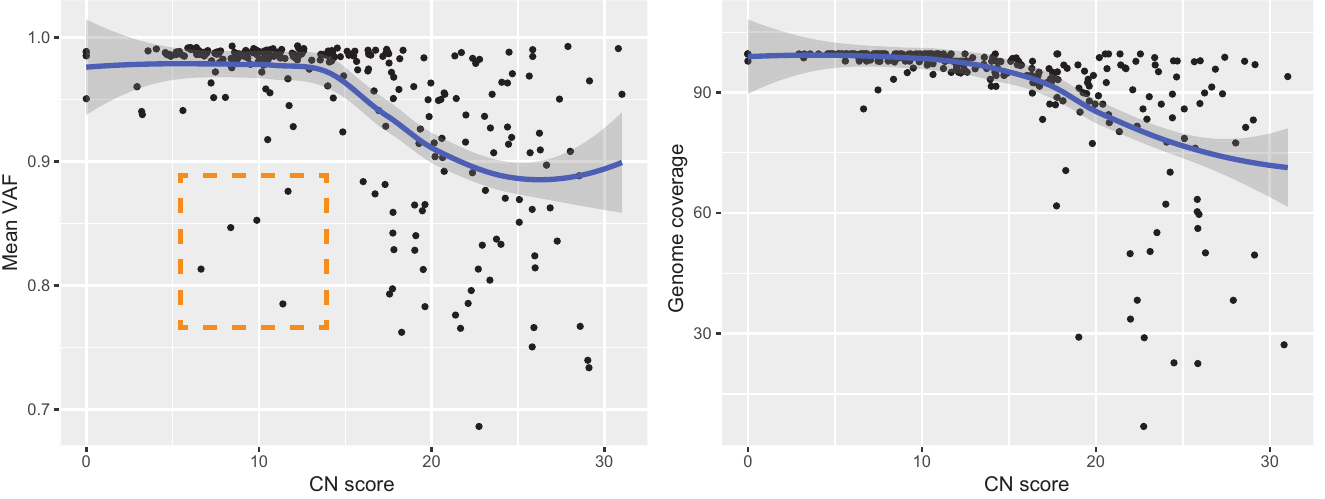
Fig 2. Genomic features in relation to RNA abundance at diagnosis. Average variant allele frequency (VAF) in function of RNA abundance (left). Genome completeness in function of RNA abundance (right). Outliers highlighted in orange. CN = Cycle Number.